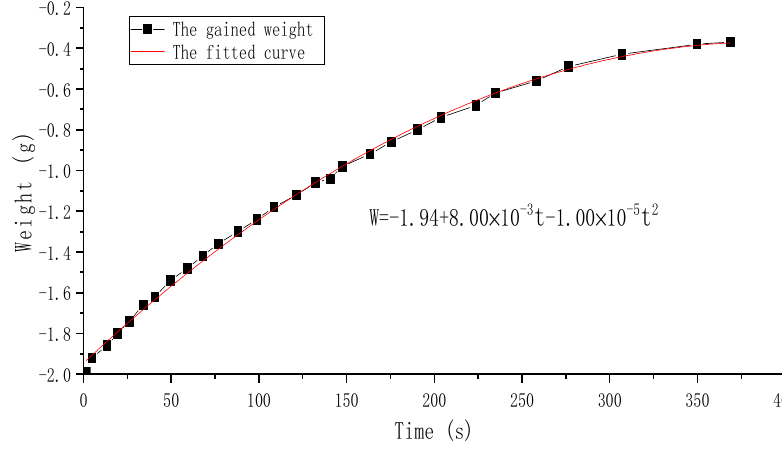
Figure 12. The relationship of siphon-caused gained weight versus